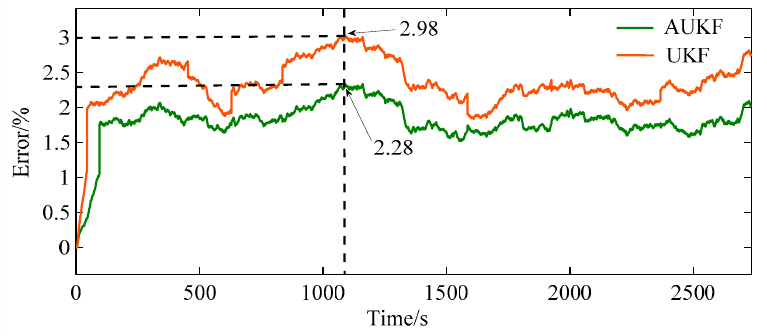
Figure 13. The model simulation errors.